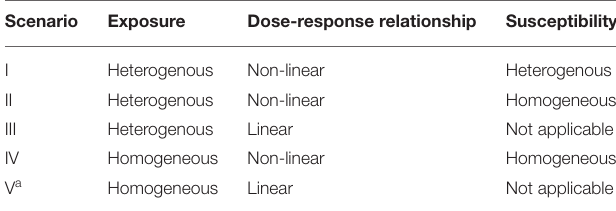
TABLE 2 | Scenarios considered in this study with a breakdown of their combinations of exposure, dose-response relationship, and susceptibility